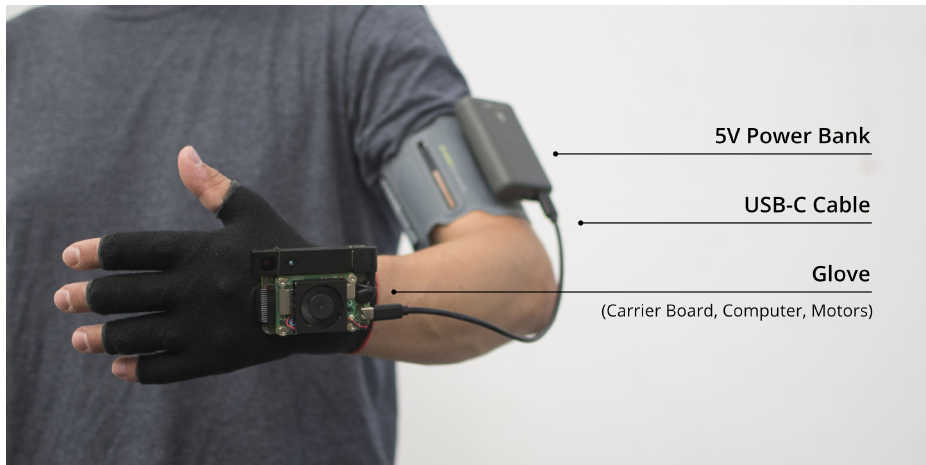
Figure 1. The final prototype with labeled